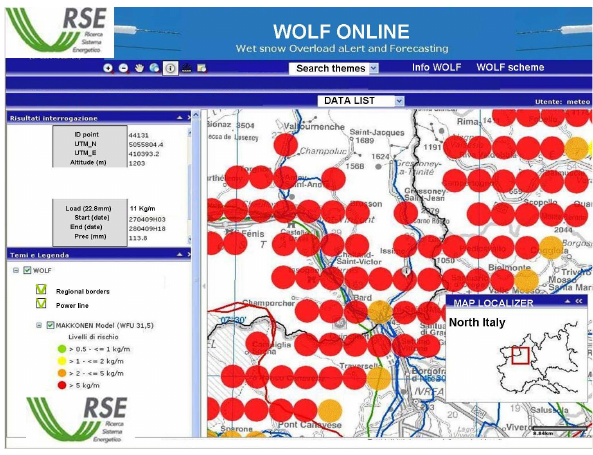
Fig. 8. Web-GIS Archive tools: the output of WOLF provided sev- eral alerts ( > 5Kgm − 1